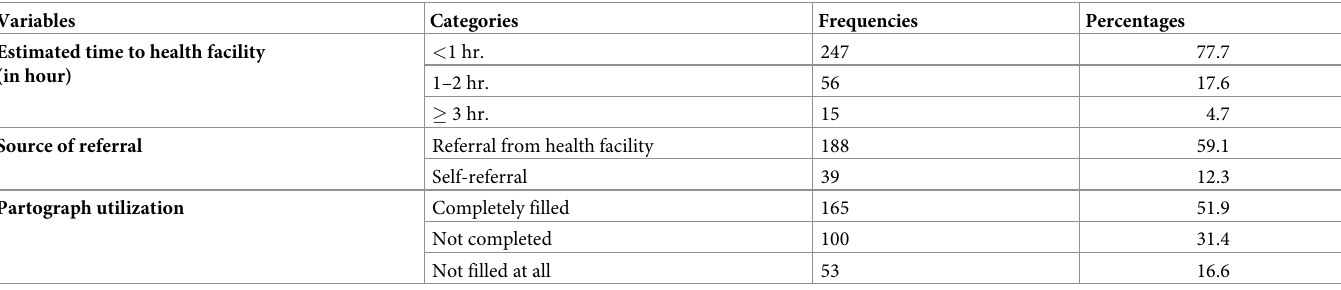
Table 3. The healthcare facility-related characteristics of mothers who gave birth at public health facilities in Mojo town, Central Ethiopia, 2019 (n = 318).